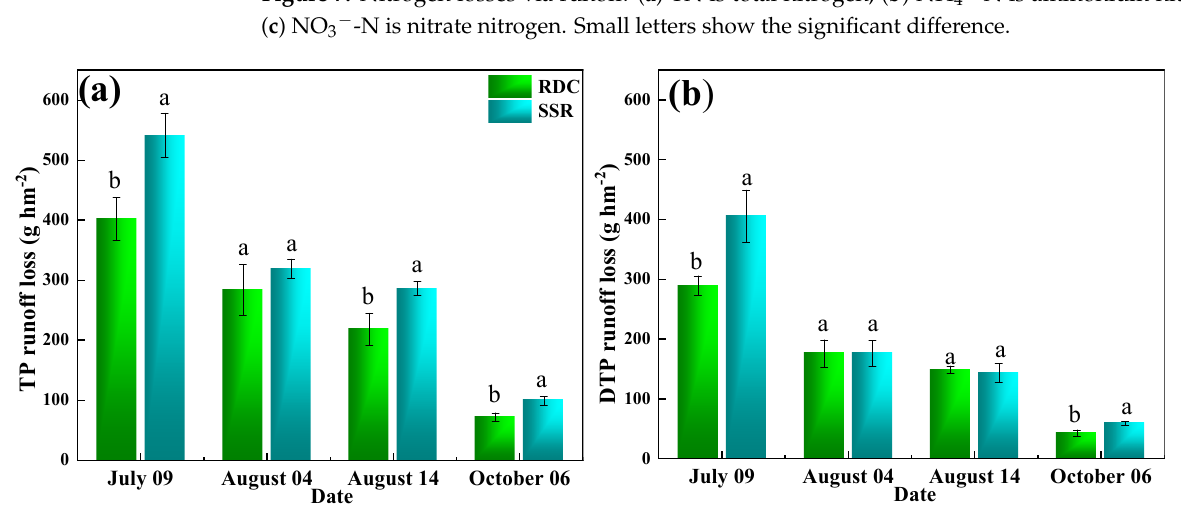
Figure 8. Phosphorus losses via runoff. (a) TP is total phosphorus, (b) DTP is dissolved total phos- phorus. Small letters show the significant difference.